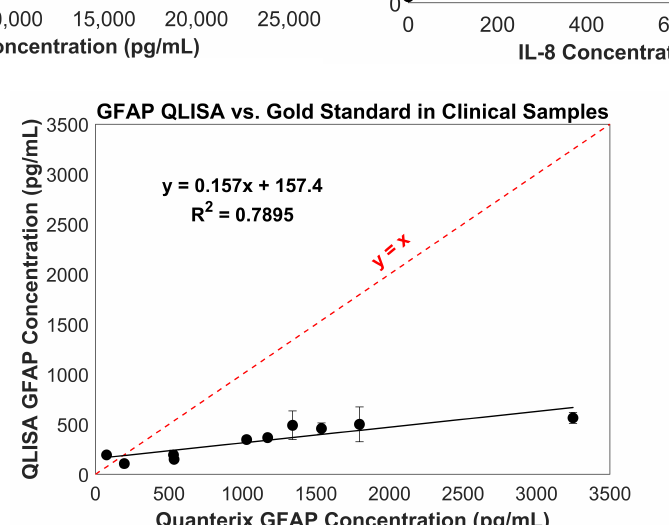
Figure 2. QLISA standard curves for GFAP in ( A ) spiked human serum and ( B ) spiked human whole blood, ( C ) IL-6 in spiked buffer, and ( D ) IL-8 in spiked buffer. Each data point represents three replicates ( n = 3). ( E ) Comparison of the GFAP concentrations determined by the Quanterix Simoa ® assay and by the QLISA method for ten clinical serum samples. The dashed red line represents the line y = x , and the solid black line represents the trend between the Quanterix GFAP concentration and the QLISA GFAP concentration. Each black dot represents a serum sample from a different donor. Replicates ranged from n = 1 to n = 5 depending on the volume of the serum sample. All error bars throughout the figure are standard error of the